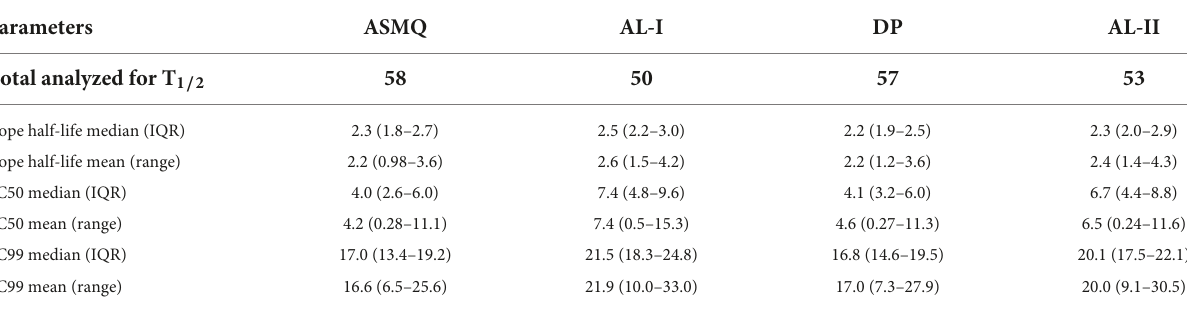
TABLE 2 Parasite clearance